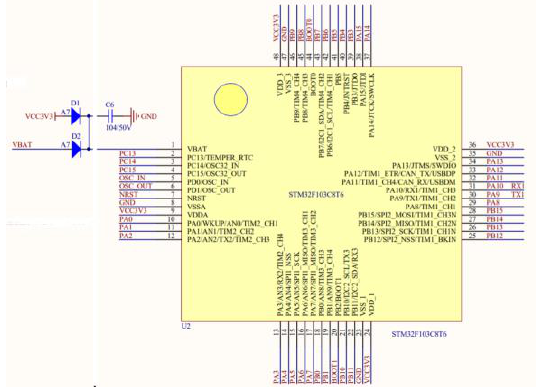
Fig. 2 . The pin diagram of